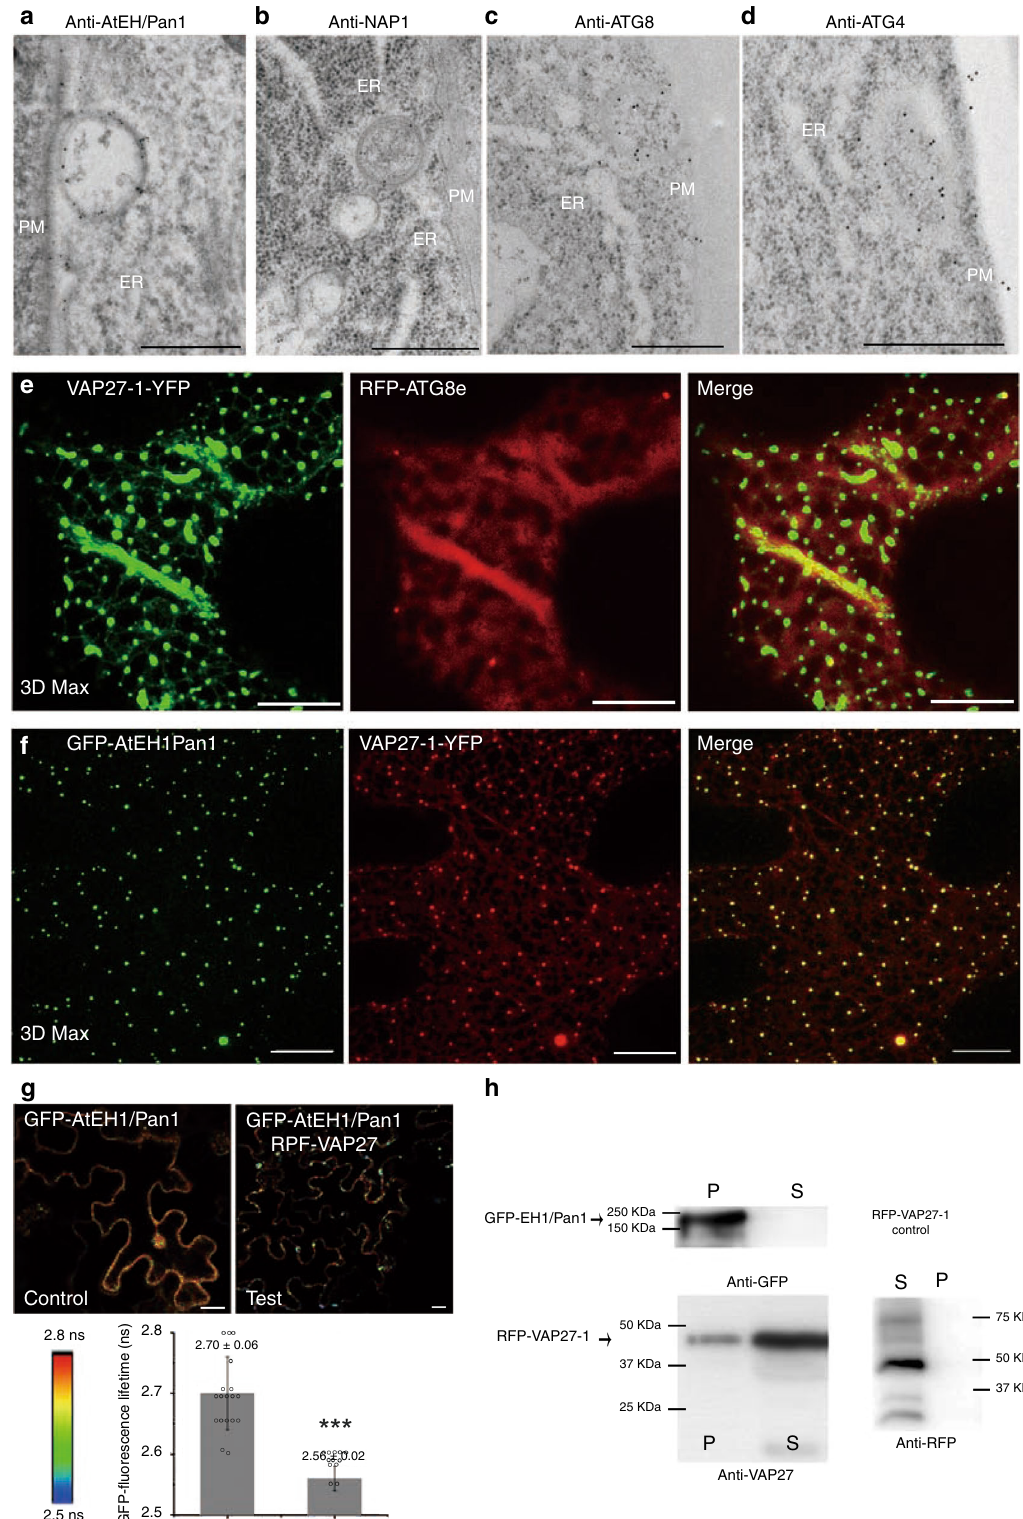
mutants may also re fl ect disruption of the endocytic pathway. As AtEH/Pan1 proteins, as part of TPC are known to regulate endocytosis 21 . Our data presented here favours the hypothesis that endocytosis at the EPCS is the fi rst step into the autophagic pathway. However, the exact regulation and crosstalk between the